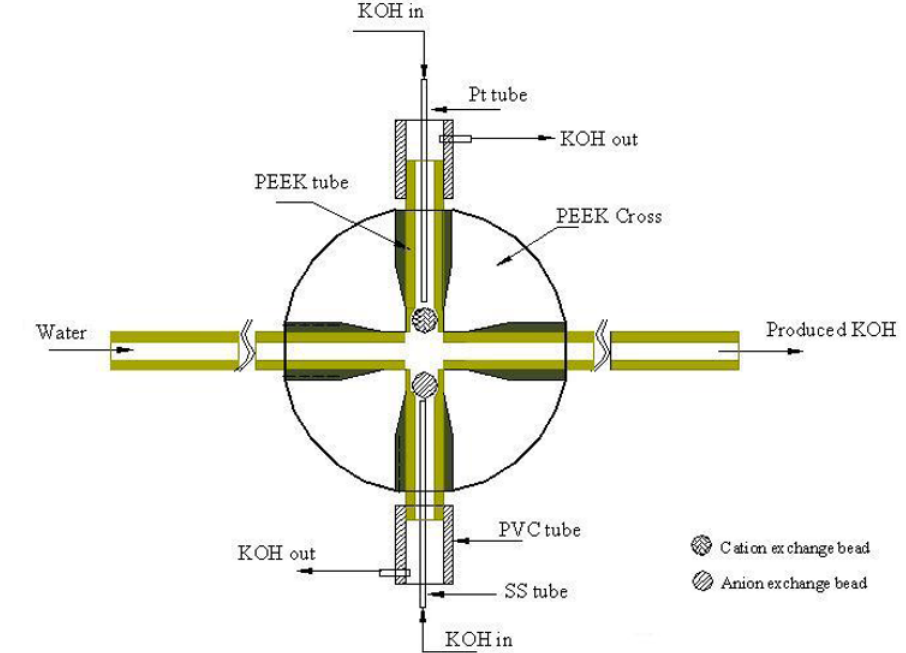
Figure 1. The scheme of two-membrane electrodialytic eluent